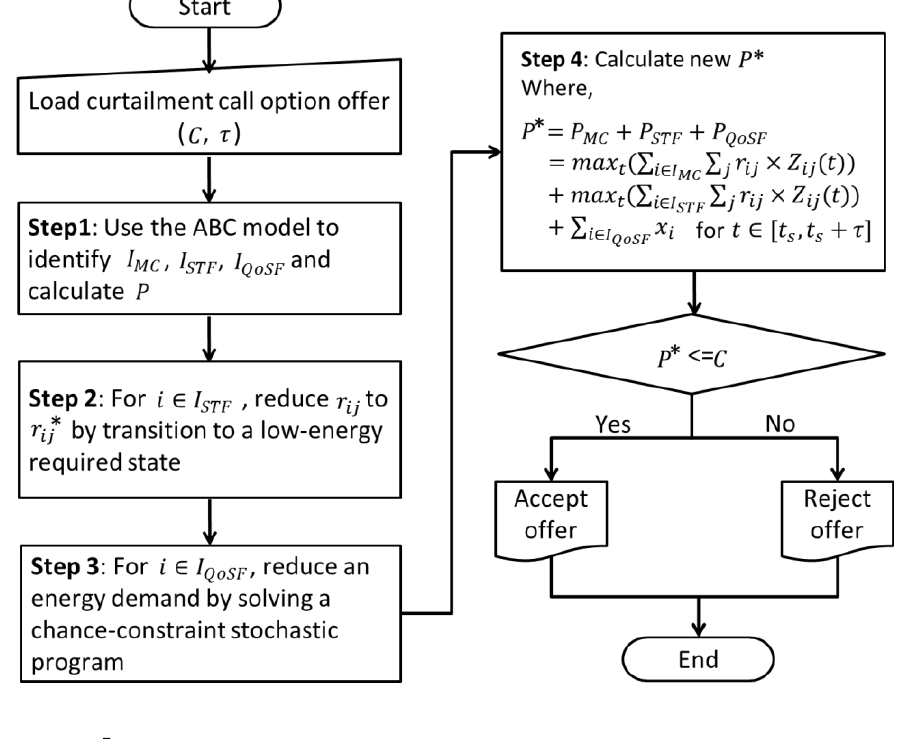
Figure 5. Overview of energy demand response call option assessment decision